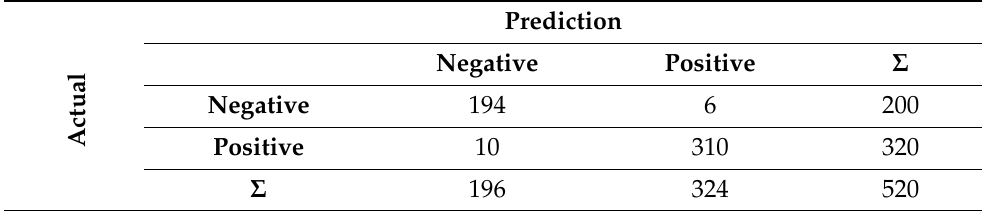
Table 7. Confusion Matrix of Random Forest Classification.